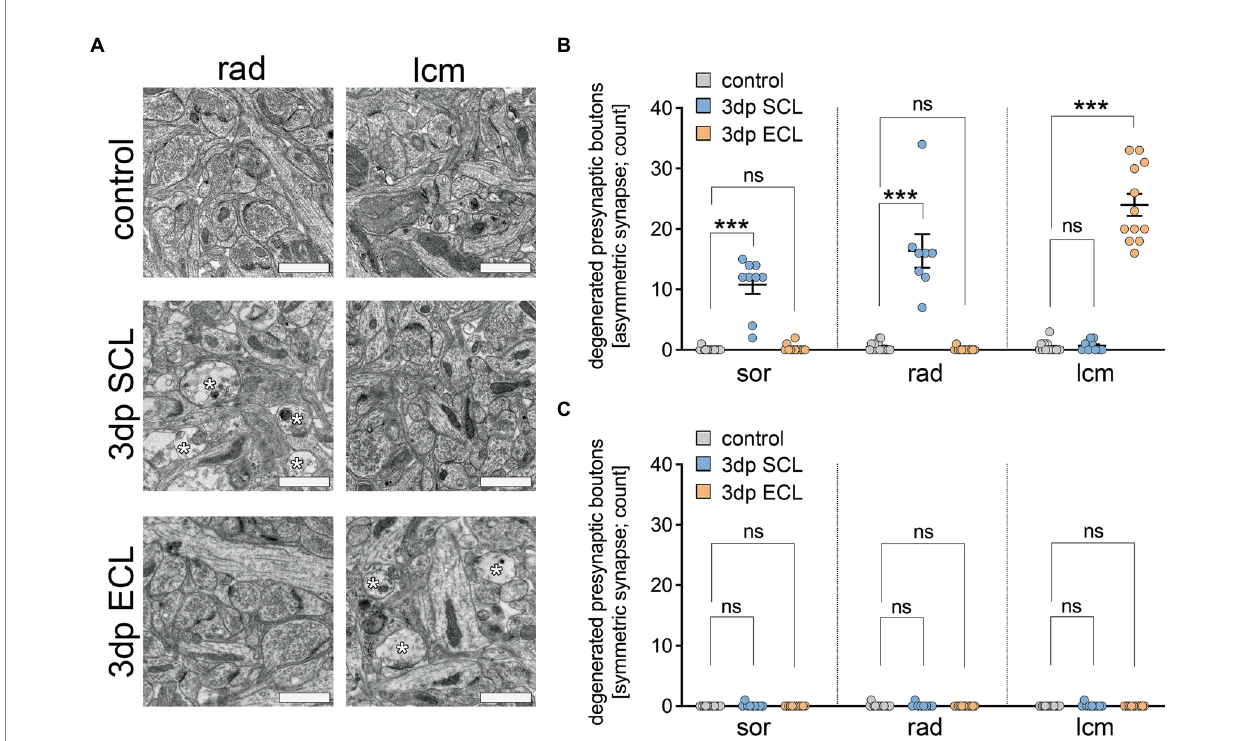
FIGURE 2 SCL and ECL lead to layer-specific degeneration of asymmetric synapses in the CA1 region. (A) Transmission electron microscopy was used to visualize a layer-specific degeneration of asymmetric synapses (membrane disintegration, swelling, loss of synaptic vesicles; white asterisks) in the CA1 region of entorhino-hippocampal tissue cultures. Scale bar, 1 μ m. (B) Following SCL, a significant degeneration of presynaptic boutons of asymmetric synapses was evident in both str. oriens (sor) and str. radiatum (rad) but not in the str. lacunosum-moleculare (lcm). However, following ECL reversed effects were observed, e.g., a degeneration of asymmetric synapses in the lcm but not in either sor or rad (upper panel, n control = 15 images, n SCL = 9 images, n ECL = 12 images from 3 cultures each, Kruskal-Wallis test followed by Dunn’s posthoc correction; in rad (SCL), one image was excluded from analysis due to preparation artifacts). (C) In presynaptic boutons of symmetric synapses no degeneration was detectable following either SCL or ECL (lower panel, n control = 15 images, n SCL = 9 images, n ECL = 12 images from 3 cultures each, Kruskal-Wallis test followed by Dunn’s posthoc correction; in rad (SCL), one image was excluded from analysis due to preparation artifacts). Individual data points are indicated by colored dots. Values represent mean ± s.e.m. (*** p < 0.001, ns - non significant